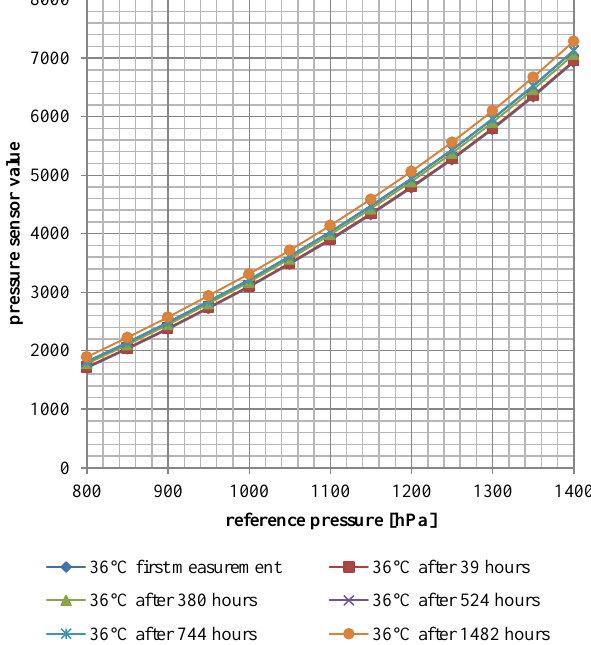
Figure 22. Pressure curves of different calibrations at 36 ◦ C after different periods of the accelerated life time test at 60 ◦ C in saline